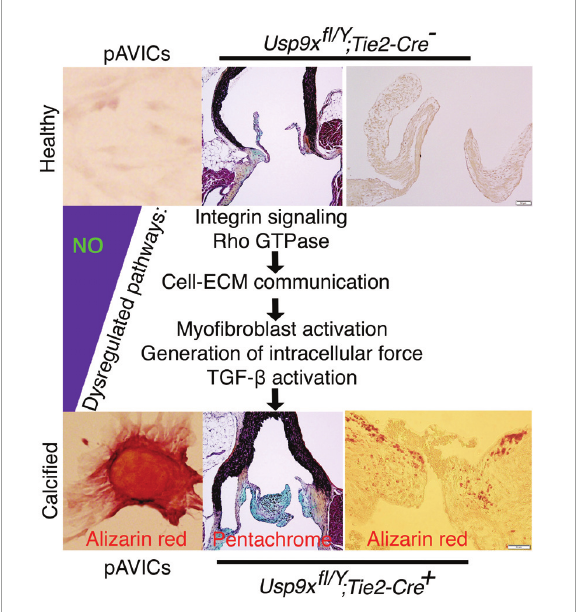
FIGURE5 Nitric oxide (NO) inhibits the process of aortic valve calcification. Schematic showing the proposed model where calcification is initiated with reduced NO availability that perturbs integrin signaling pathway, cell-extracellular matrix (ECM) interactions, followed by dysregulation of various cellular signaling